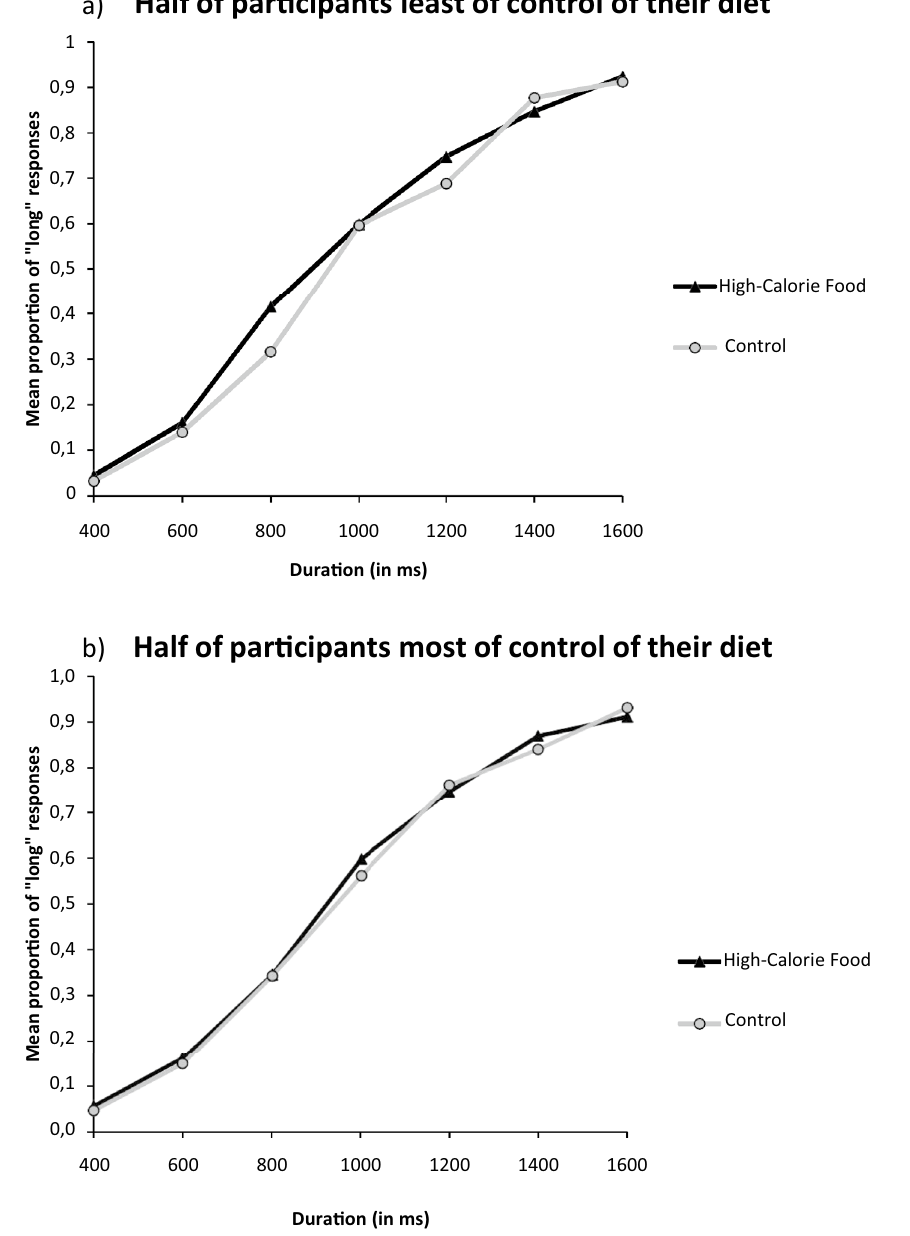
Figure 6. For graphical reasons only, this graph divides the participants of Experiment 2 according to their level of diet control. The upper panel shows the mean proportion of “long” responses plotted against stimulus duration for each picture condition associated with the half of the participants who control their diet least. The lower panel shows this same bisection task for the half of the participants who control their diet